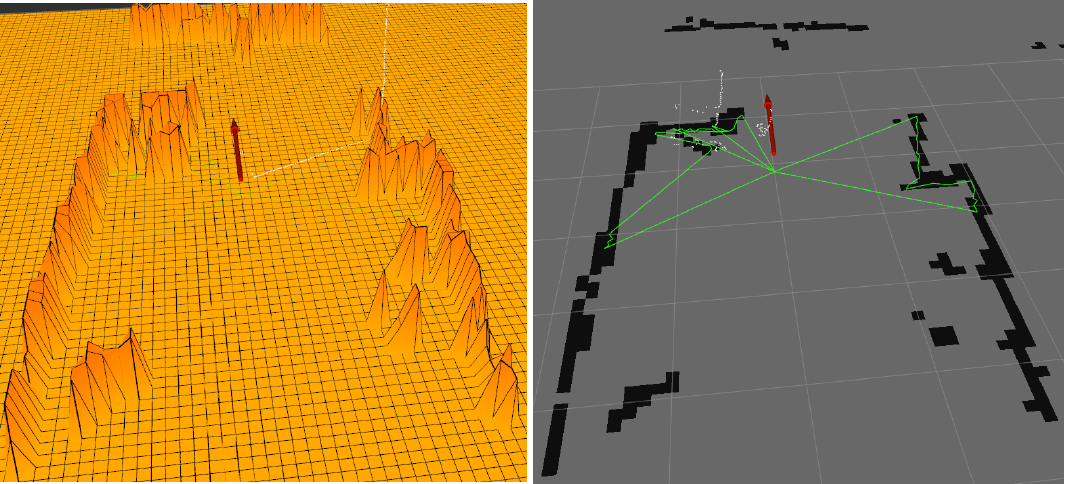
Figure 14. Occupancy grid map from global